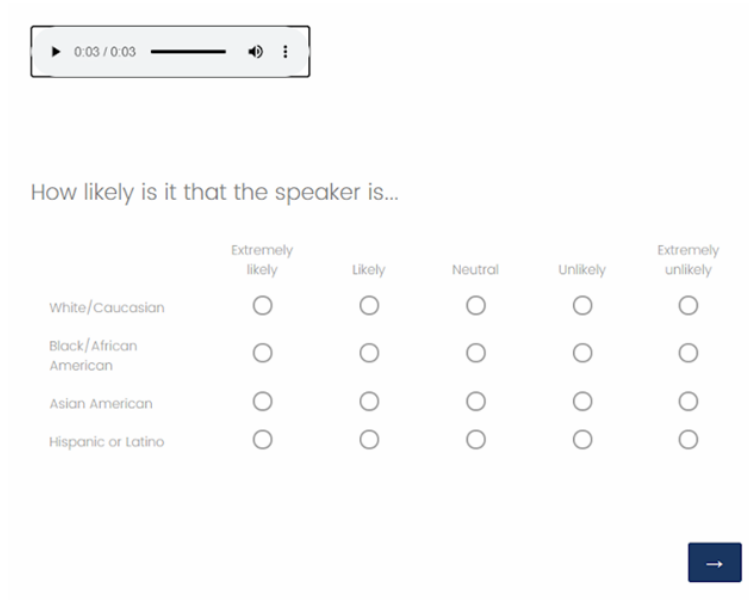
Figure 1. An example of the first race/ethnicity rating Likert scale in block A.